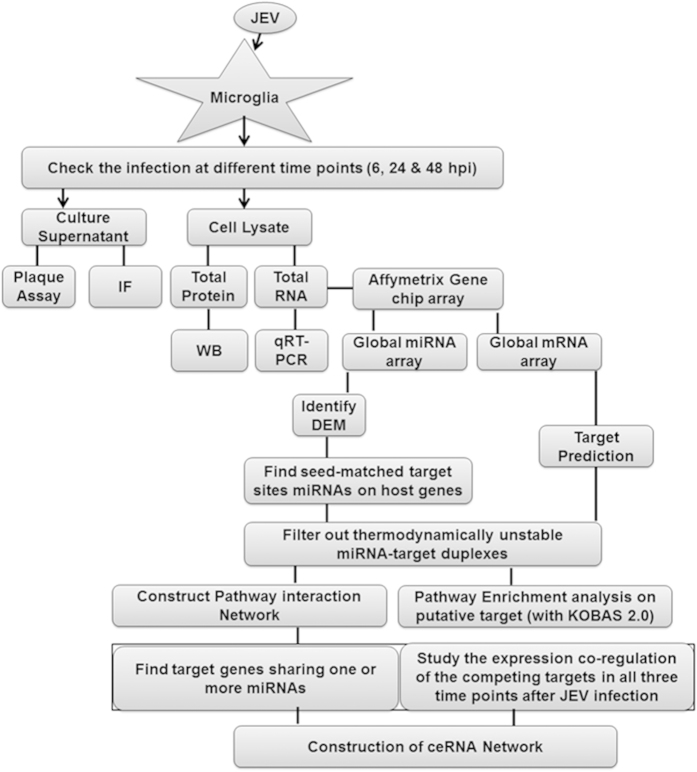
Schematic representation of mRNA and miRNA analysis workflow.